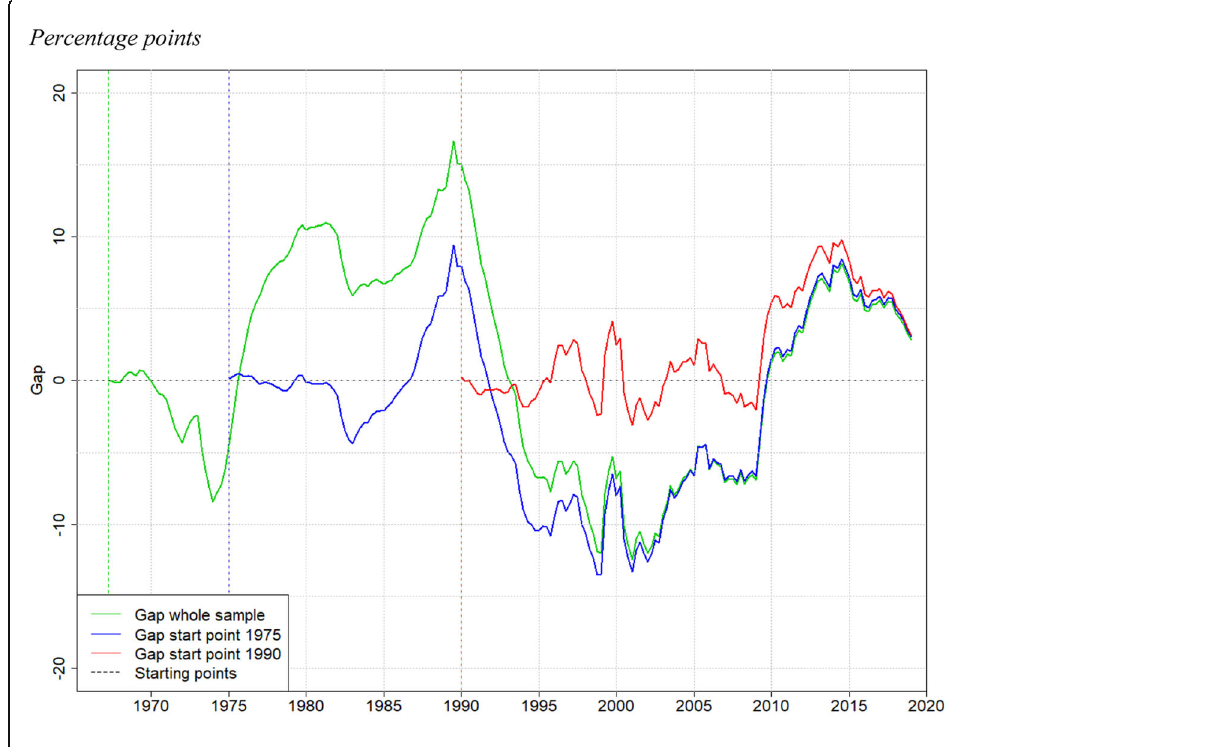
Fig. 9 Credit-to-GDP gap, start-point problem assessment. Percentage points